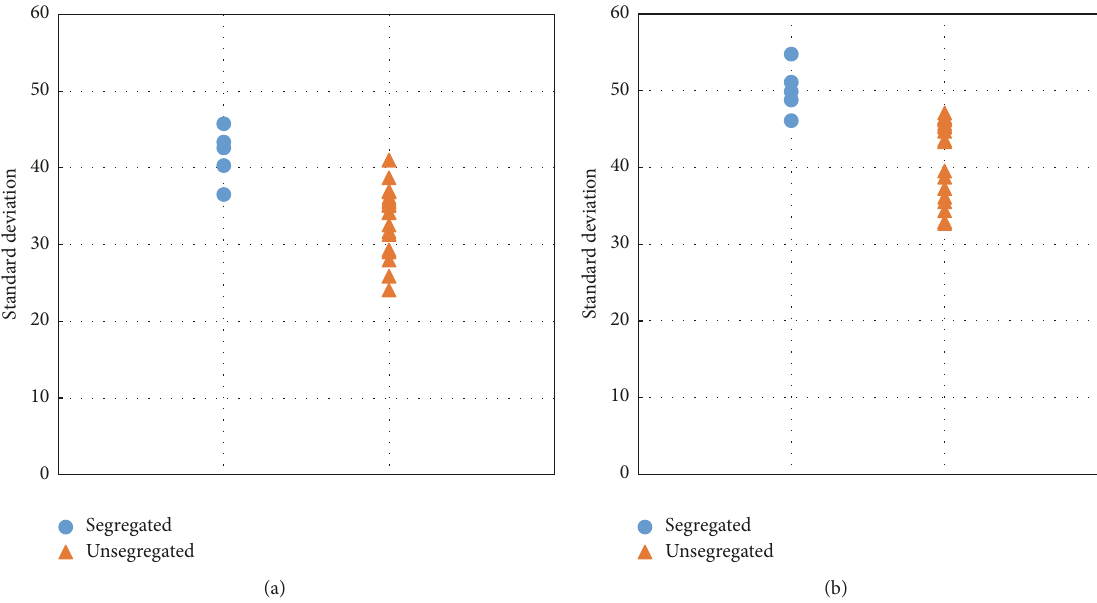
Figure 3: Standard deviation of frequency histogram in (a) site location 1 and (b) site location